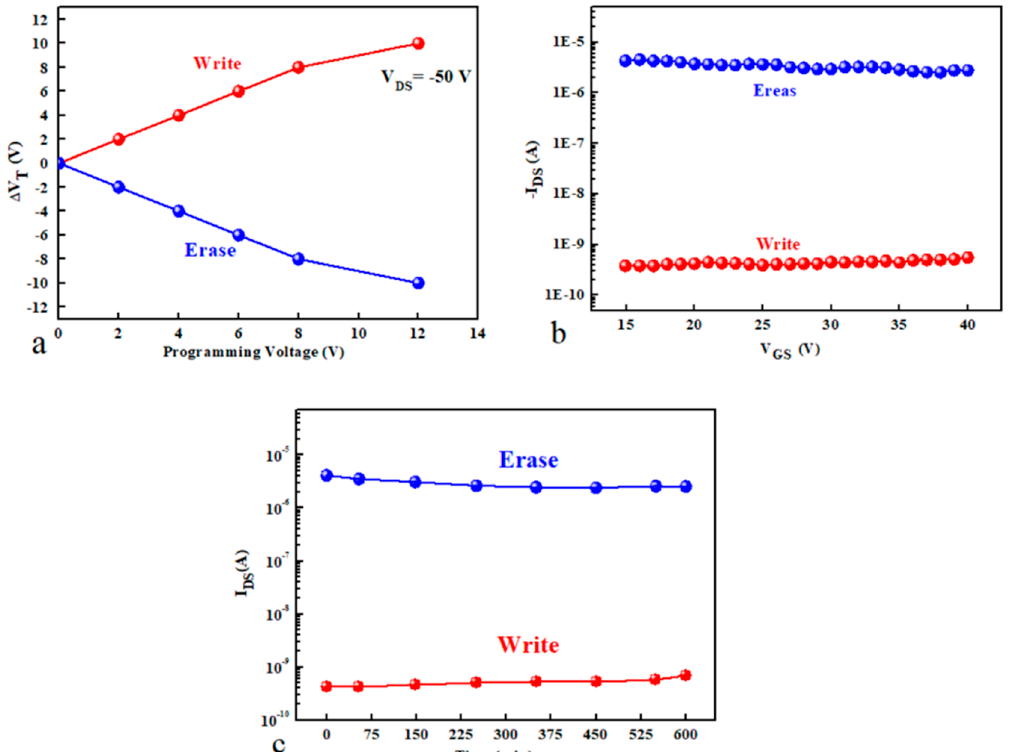
Figure 7. Programming characteristics of TIPS-pentacene based OTFMT. ( a ) The effect of the programming voltage (2 s pulses) on the threshold voltage shift( Δ V T ), ( b ) write and erase processes by applying a negative and positive pulse voltage, respectively as a function of gate voltage and ( c ) charge retention characteristics of the OTFMT.